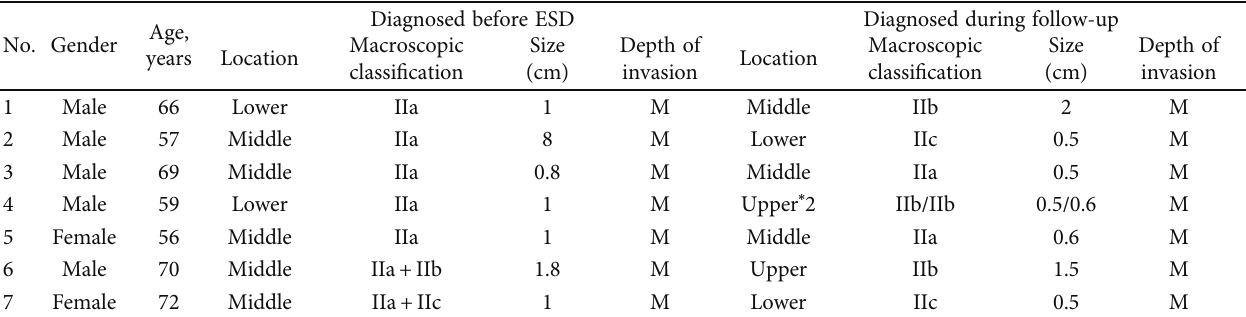
Table 5: SMEGC lesion diagnosed during follow-up within 1 year ( n = 7 ).